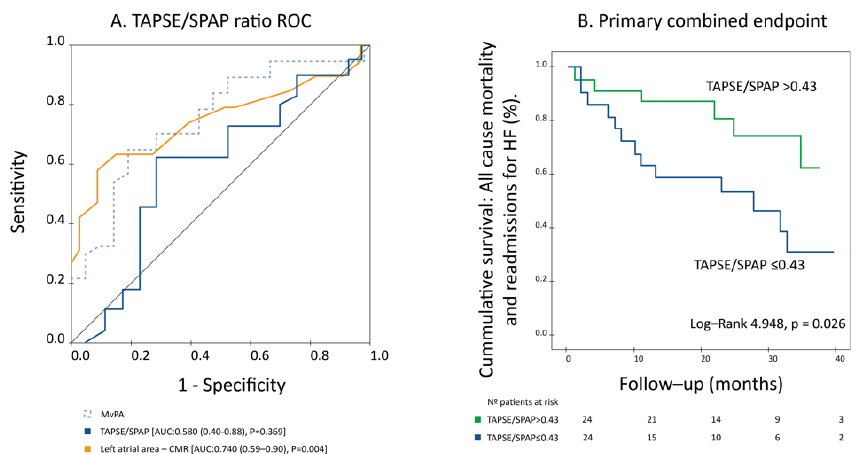
Figure 4. ( A ) Left atrial area displayed lower sensitivity than mvPA for the detection of the primary combined endpoint, despite a similar AUC value, while TAPSE/SPAP ratio had a much lower performance for the prediction of the primary combined endpoint, which did not attain statistical significance. ( B ) Notwithstanding, a TAPSE/SPAP ratio ≤ 0.43 was associated with higher rates of the primary combined endpoint.